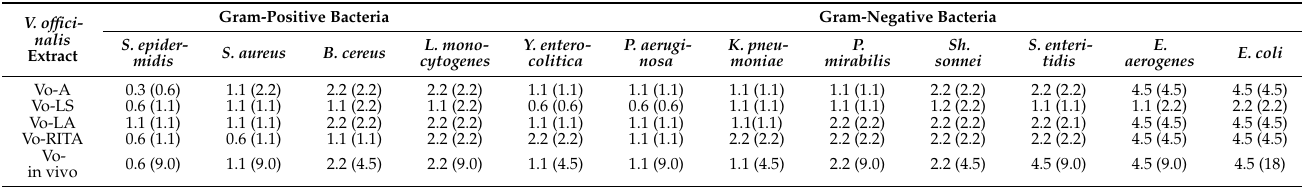
Table 5. MIC (MBC) values (mg/mL) of extracts of V. officinalis in vitro cultures; agar (Vo-A), sta- tionary liquid (Vo-LS), agitated (Vo-LA) and bioreactor cultures (Vo-RITA) and of plant material (Vo-in vivo).